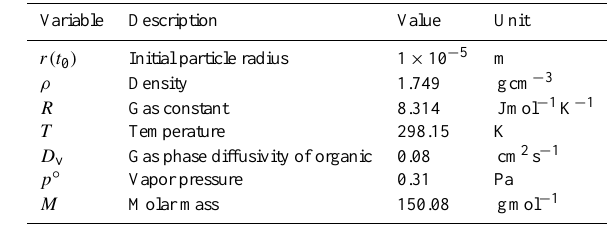
Table C1. Definitions and values for parameters in Eq. (C1). Table D1. Definitions and values for parameters in Eq.